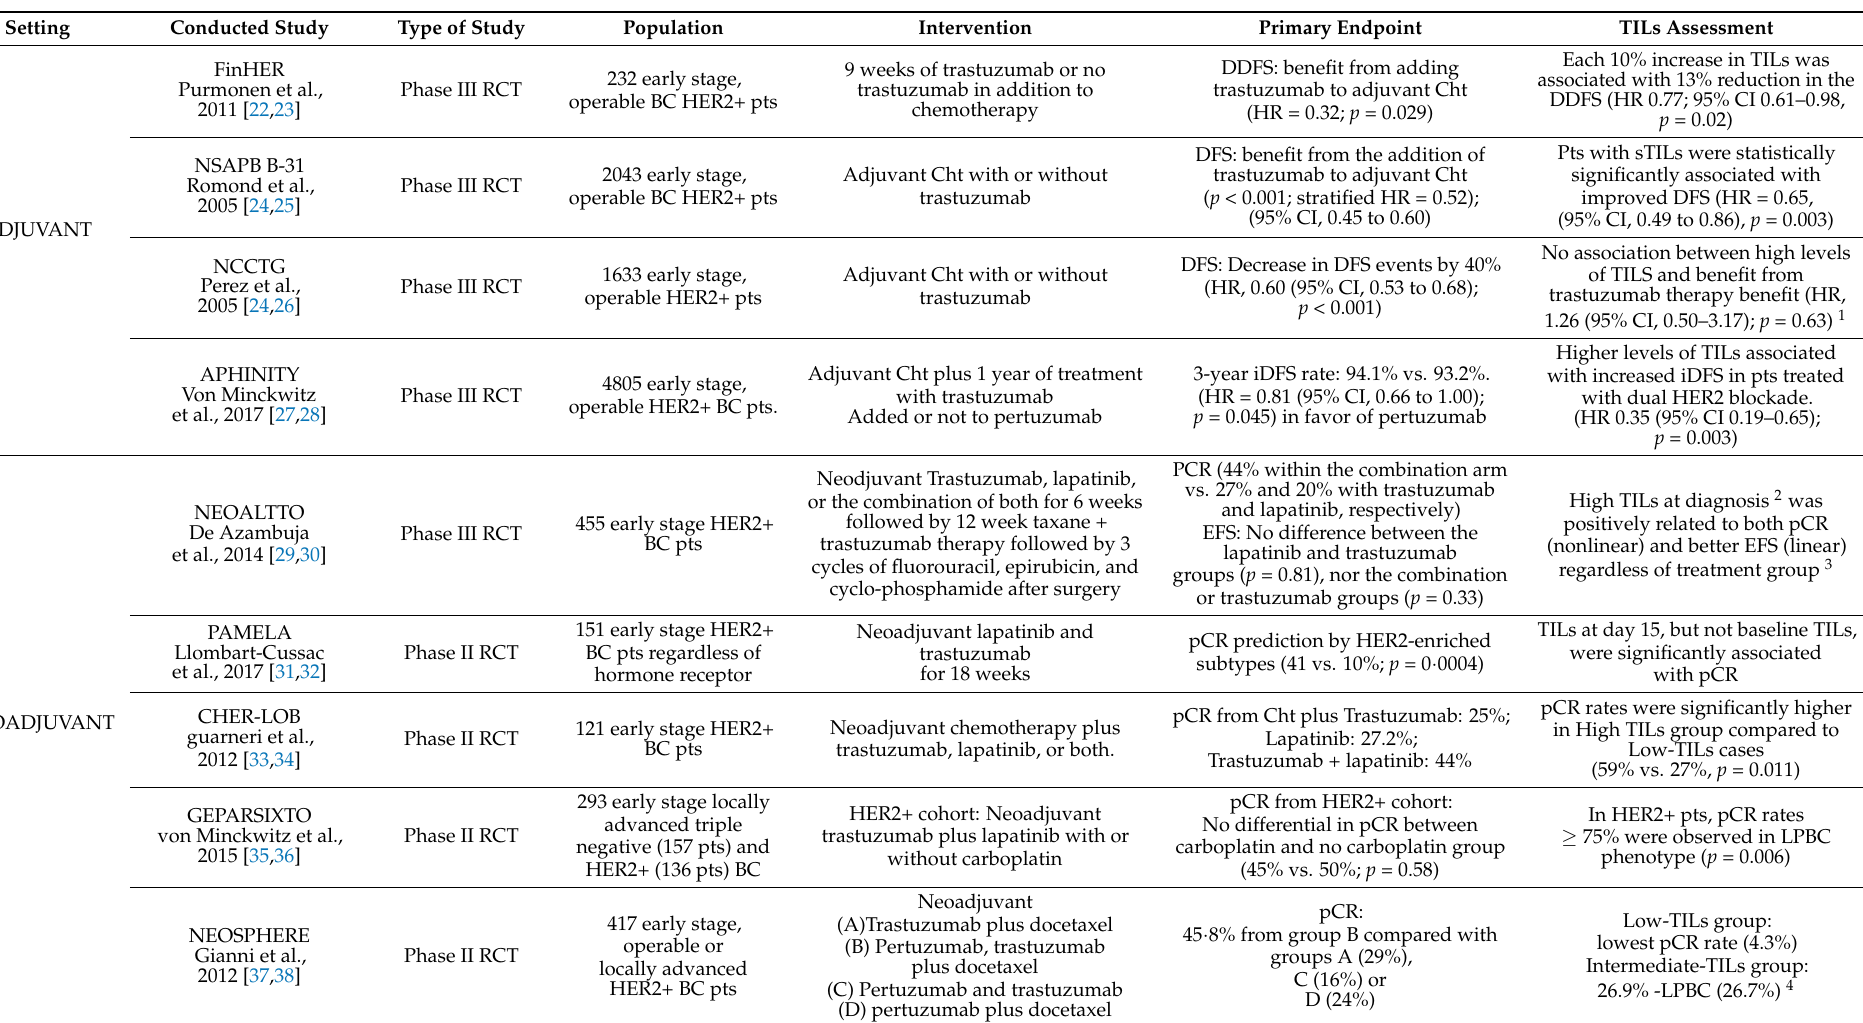
Table 1. TILs assessment in different HER2+ trials in the adjuvant, neoadjuvant and metastatic settings.